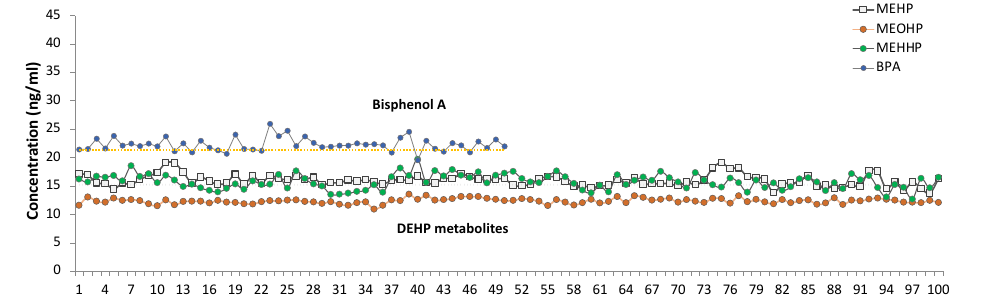
Figure 4. Reproducibility of the matrix QC spiked with MEHP, MEHHP and MEOHP and measured by UHPLC/QTOF over three years, i.e., from 2015 to 2018 (N = 100). The average values ± standard deviation (ng/mL) measured for quality control (QC) samples of standard metabolites were: MEHP: 15.96 ± 1.04; MEHHP: 15.73 ± 1.31; MEOHP: 12.34 ± 0.45, respectively. For BPA we assessed stability and reproducibility in n = 50 QC together with DEHP metabolites in LC/MS analysis and average value was 22.30 ± 1.17 ng/mL and RSD = 5.25%. The low variation of QC samples, prepared at the beginning of the study and stored at − 20 °C, showed that DEHP metabolites and BPA are stable also if stored at − 20 °C.